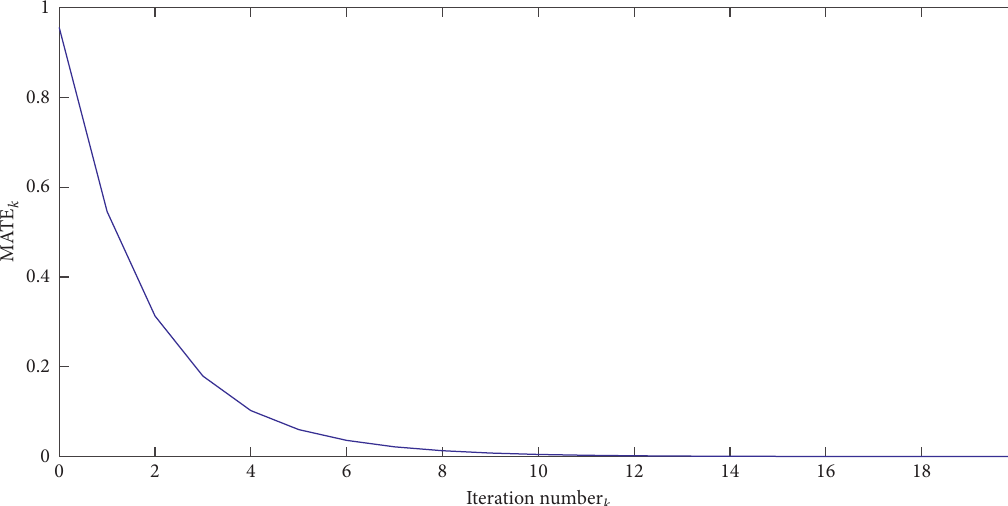
Figure 4: Under ILC law (45), the profile of tracking error index MATE